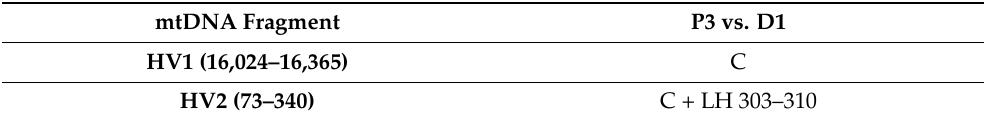
Table 4. Results of the mtDNA haplotype concordance study between the NN male and Jann Dusza’s sister.